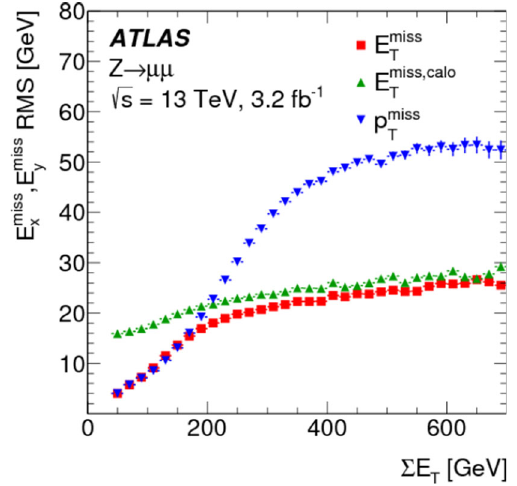
Fig. 14 Comparison of the reference E miss olutions of the track-only-based variant p miss